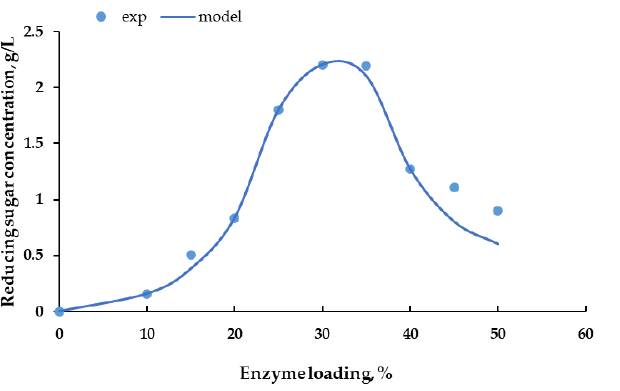
Figure 5. Effect of enzyme concentration on the reducing sugar levels after 5 h of hydrolysis time.